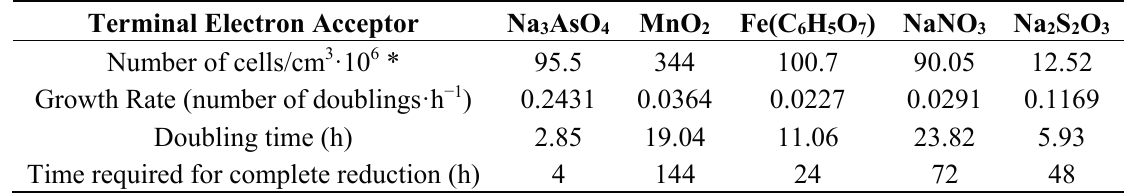
Table 4. Growth parameters of Shewanella sp. O23S during the dissimilatory reduction of arsenate, iron(III), manganese(IV) oxide, nitrate, and thiosulfate coupled with sodium lactate